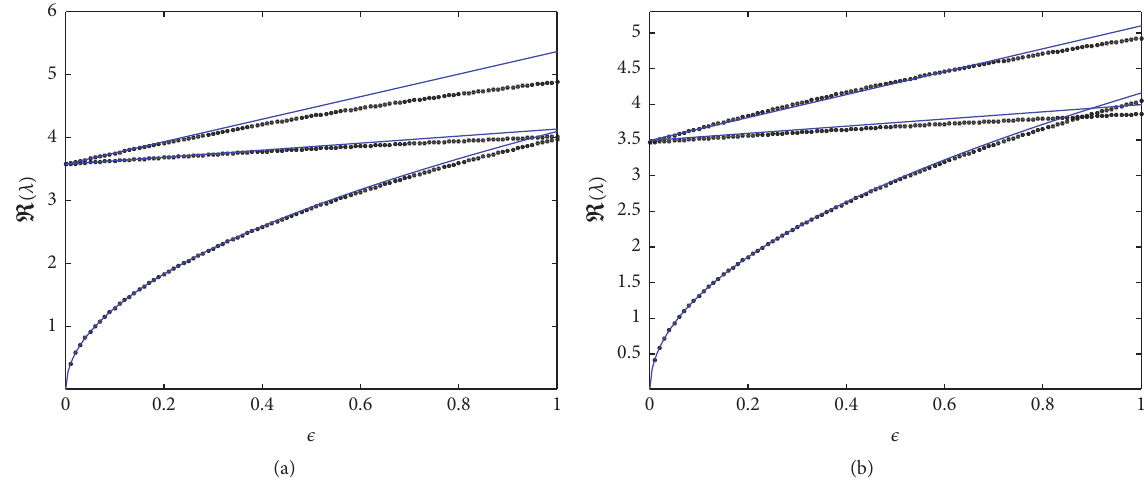
Figure 2: The same as in Figure 1 with 𝛾 = 0 (a) and 𝛾 = 0.5 (b), but for 𝜔 = 5.2 . In this case, all the eigenvalues are